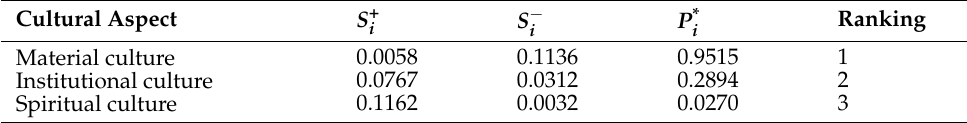
Table 3. The priority order of each Indigenous cultural aspect. Cultural Aspect Material culture